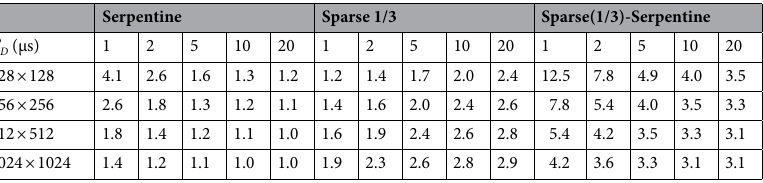
Serpentine Sparse 1/3